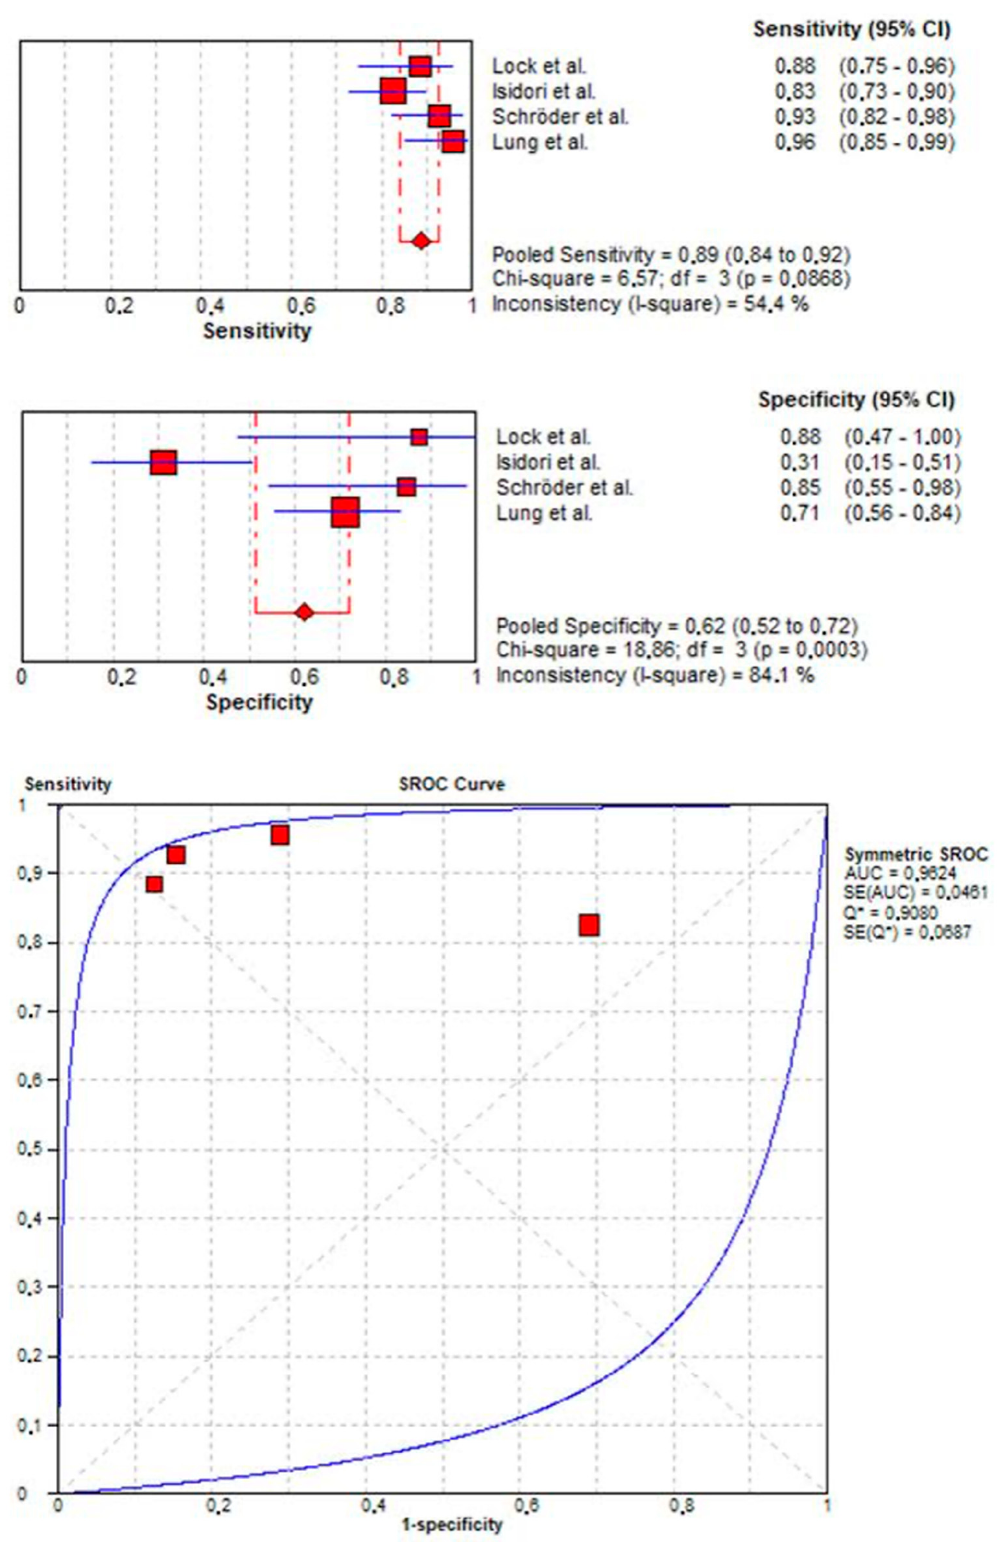
Figure 2. Pooled sensitivity, specificity, and SROC curve of CEUS in detecting neoplastic lesions.